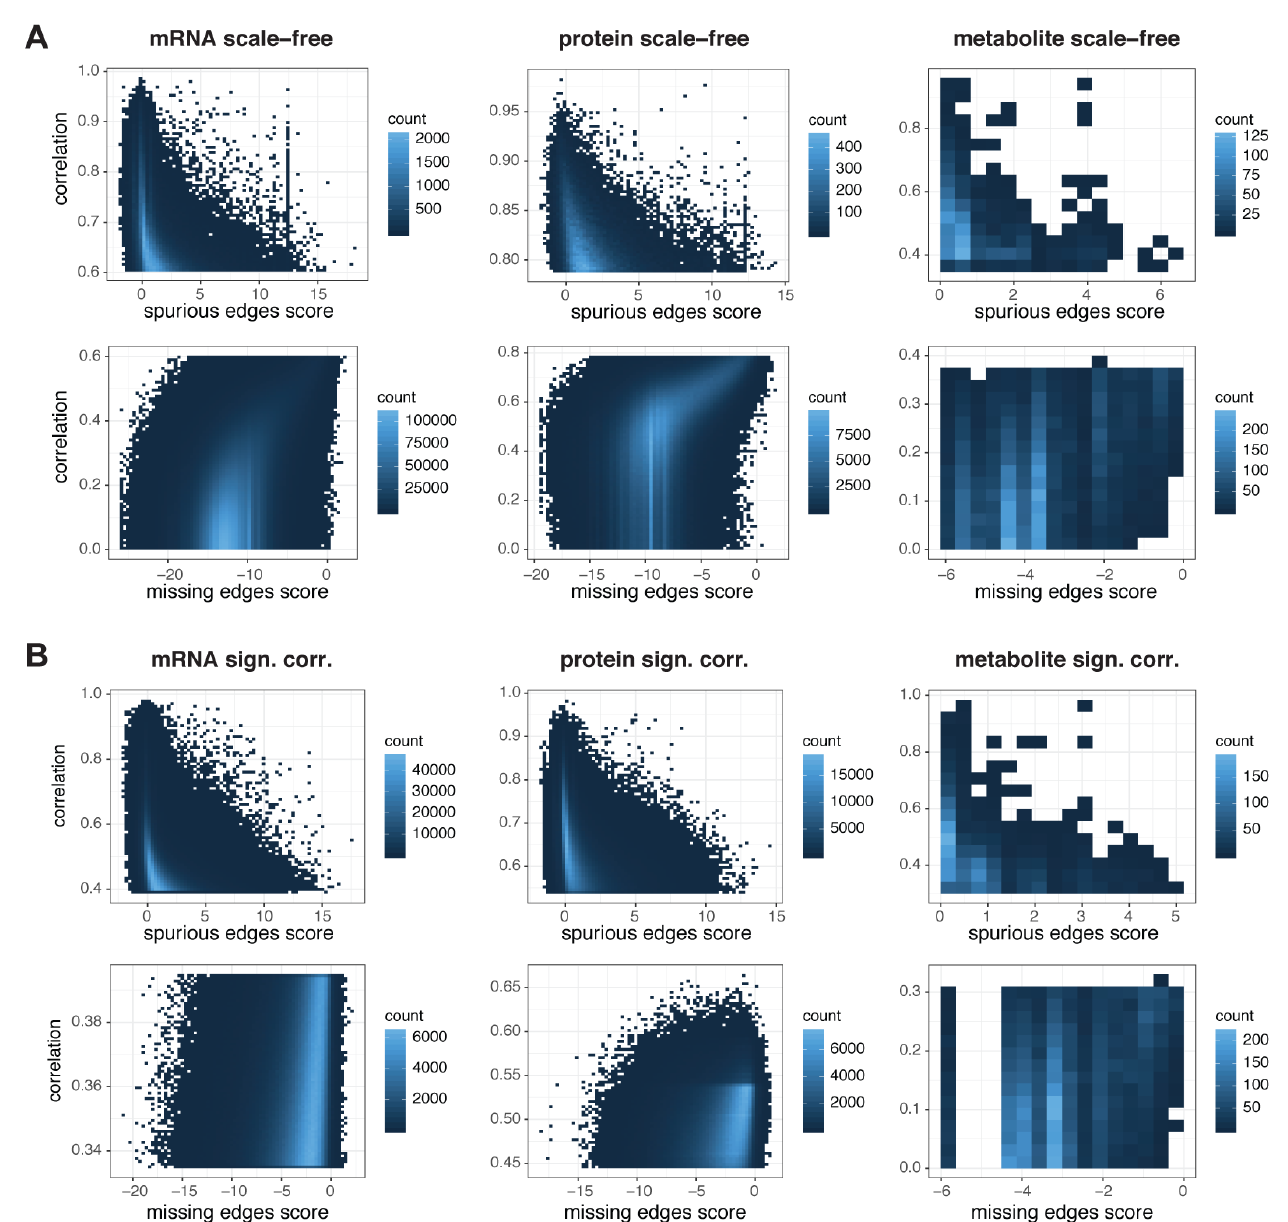
Figure 7. SBM-derived edge prediction: Validation by correlation. Relationship between edge confidence scores and edge correlations (Spearman’s correlation of the measurements at their nodes) for putatively spurious (top) or putatively missing edges between nodes of degree > 0 (bottom) for the networks reduced by criterion on scale-freeness ( A ) or significance of correlation ( B ). Edge confidence scores correlate well to edge correlations, with edges with high SBM-predicted confidence in spuriousness - edges predicted as irrelevant - having lower correlations, edges with high SBM-predicted confidence in missingness - edges predicted as relevant - having higher correlations. Please note that for the protein network reduced by significance of correlation, due to missing values in the dataset, a fixed significance threshold leads to different correlation thresholds and thus the correlation value boundary is blurred ( B ,